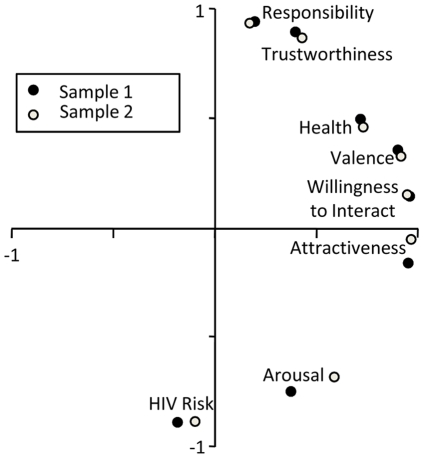
Factor loadings of explicit person impression ratings (PCA, x-axis represents factor 1, y-axis factor 2) from Sample 1 and Sample 2.